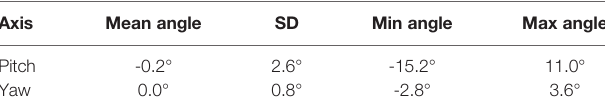
The mean, standard deviation, minimum, and maximum of the rotation angles determined from all the patients are shown in Table 3 . In the pitch axis, a systematic rotation, which is absent in the yaw axis, was observed. Meanwhile, the range and standard deviation of rotation angles were larger in the pitch axis. The distribution of prostate rotation angles in the two axes, graphically represented in Figure 5 , showed an asymmetric distribution to the negative axes and extreme rotations beyond 10 degrees in some instances.